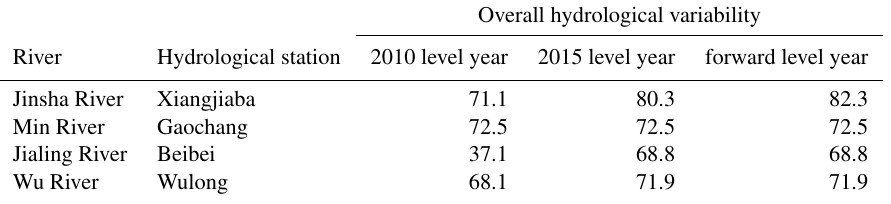
Table 5. RVA calculation results of hydrological variability of mainstream hydrological stations in different level years. Overall hydrological variability River Hydrological